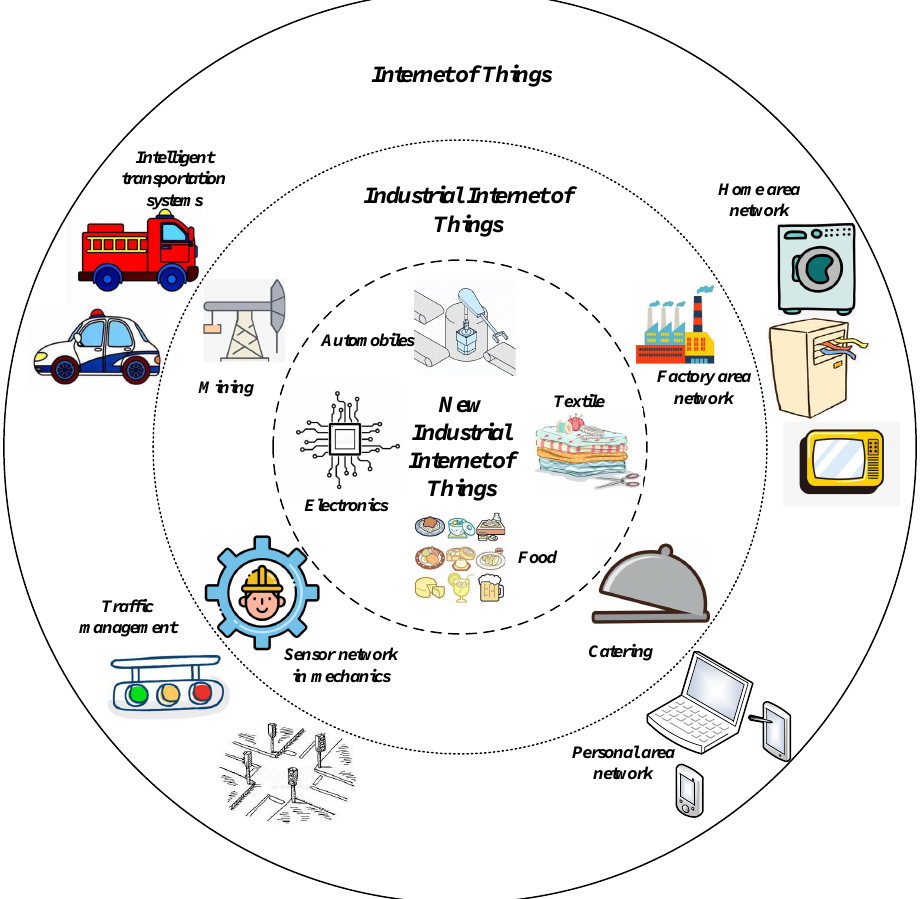
Figure 1. Application scenarios of the industrial internet of